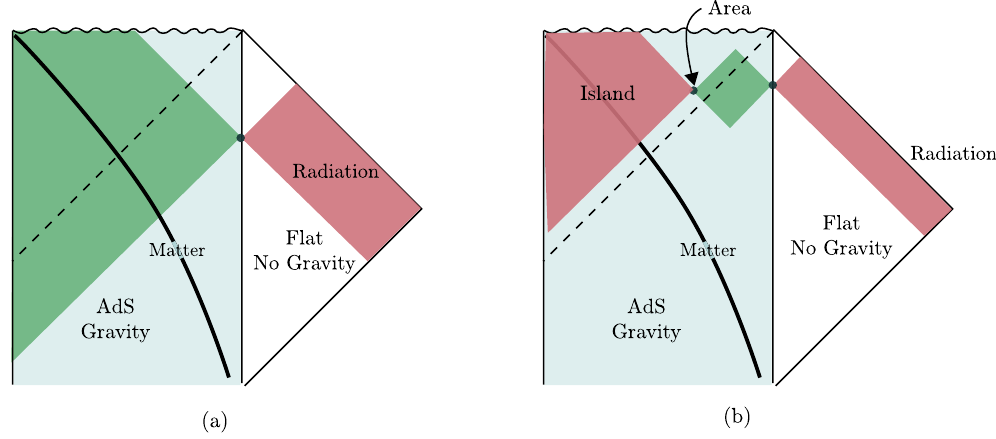
Figure 1 . We display an evaporating black hole. The vertical line separates a region on the left where gravity is dynamical from a region on the right where we can approximate it as not being dynamical. The black hole is evaporating into this second region. In red we see the regions associated to the computation of the entropy of radiation and in green the regions computing the entropy of the black hole. (a) Early times. (b) Late times, where we have an island.